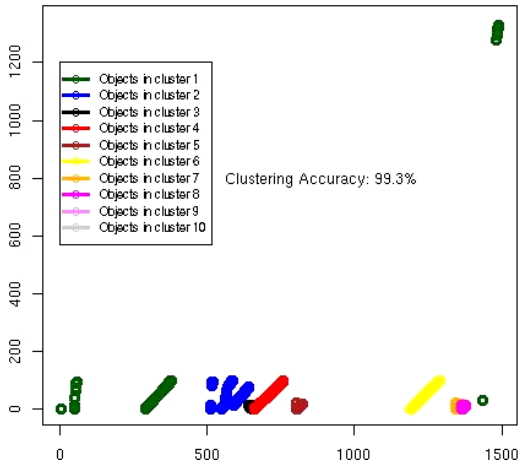
Fig. 6. Reallocated 1484 Data by KFCM nt .